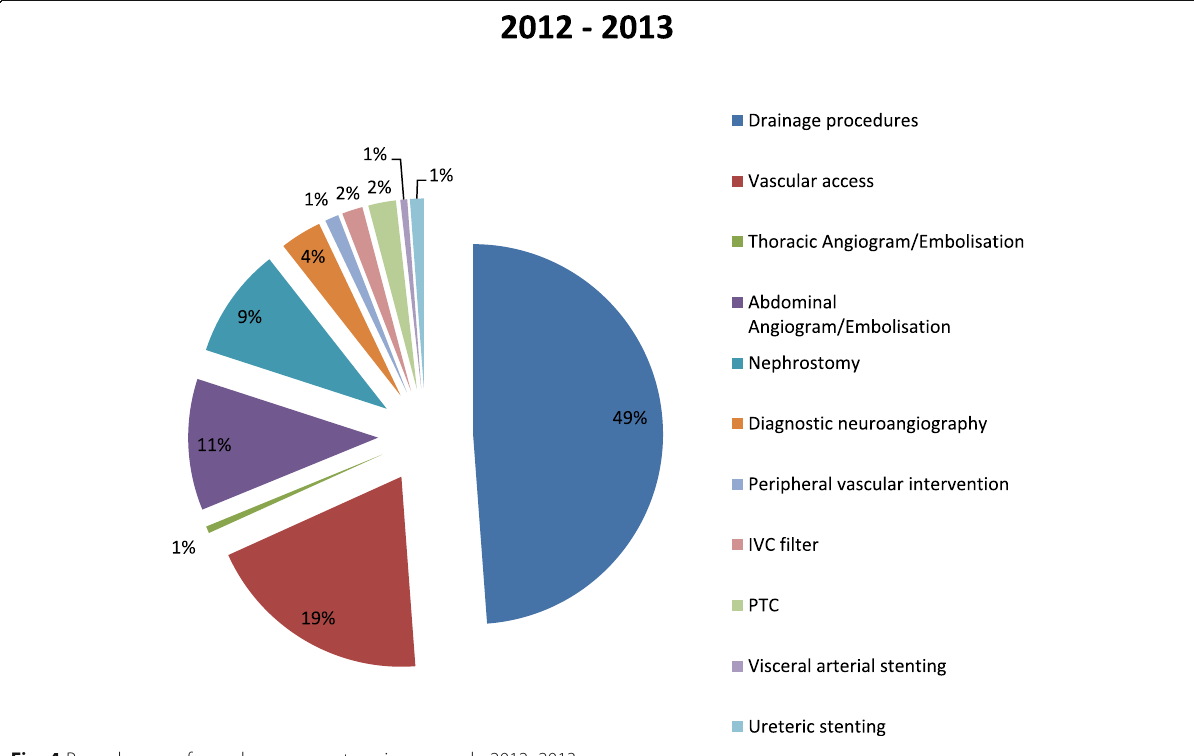
Fig. 4 Procedures performed as a percentage in year cycle 2012 – 2013